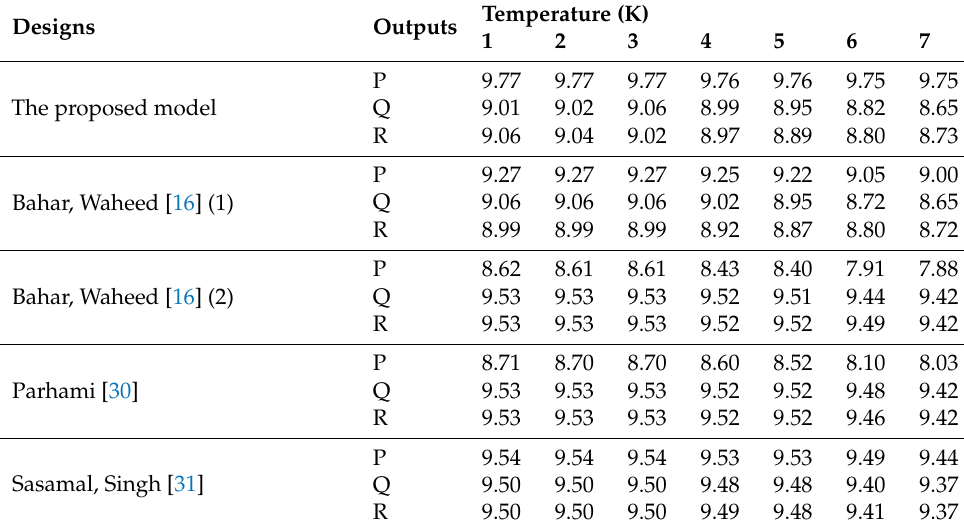
Table 5. AOP for the proposed reversible double Feynman gate.